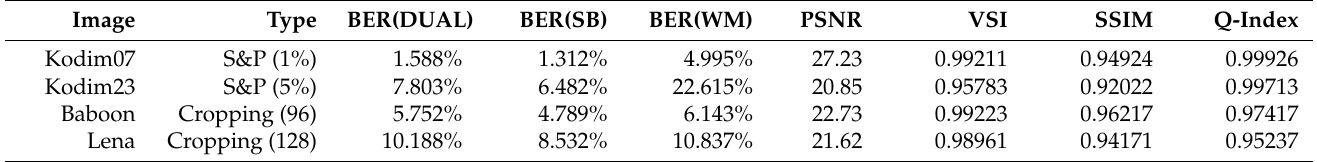
Table 15. The bit error rate and image quality under the salt-and-pepper and crop